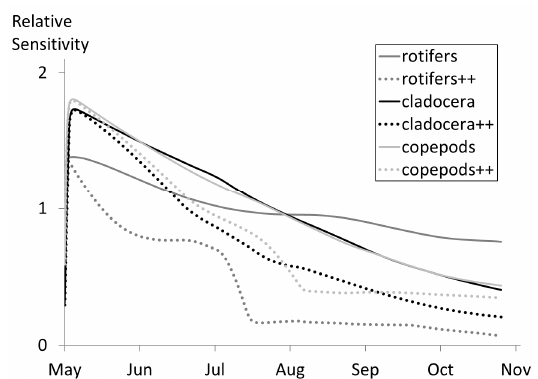
Figure 11. Results of the global sensitivity analysis when increasing (++) or decreasing (--) the initial biomass concentration of Cladocera.